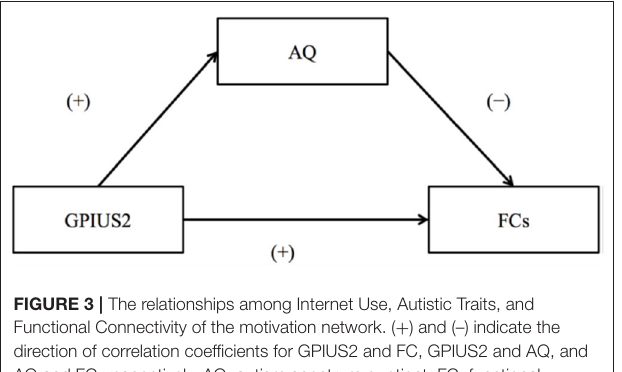
FIGURE 3 | The relationships among Internet Use, Autistic Traits, and Functional Connectivity of the motivation network. ( + ) and (–) indicate the direction of correlation coefficients for GPIUS2 and FC, GPIUS2 and AQ, and AQ and FC, respectively. AQ, autism spectrum quotient; FC, functional connectivity correlated with GPIUS2 scores; GPIUS2 scores; GPIUS2, generalised problematic internet use scale 2 [Revised from Fujiwara et al. (29)].